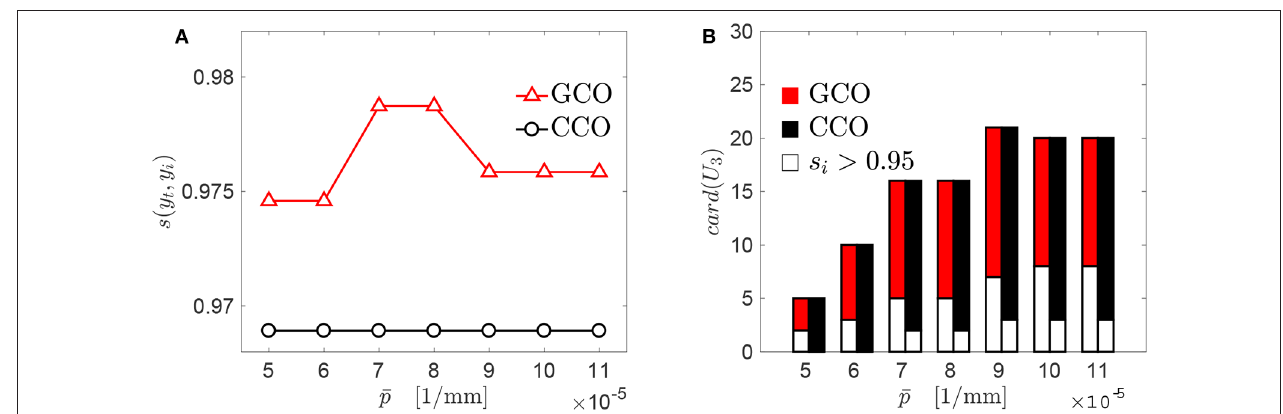
p : (A) best similarity scores obtained for each algorithm. (B) Cardinality of the set U 3 which FIGURE 8 | Sensitivity of the GCO and CCO outputs with respect to ¯ contains the new genomes obtained just before the application of the GCMMA, i.e., at the stage “GCMMA (0)” in Figure 7 .